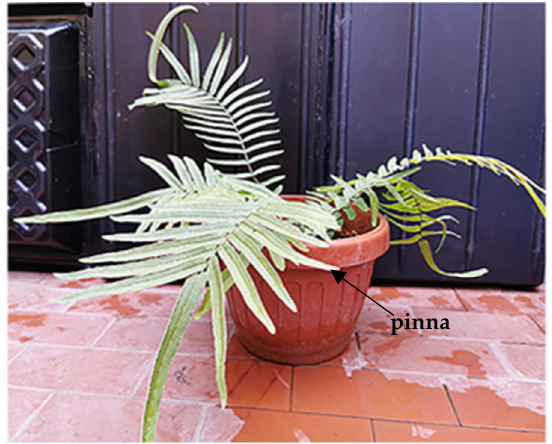
Figure 1. A P. vittata plant grown in naturally As-rich soil under greenhouse conditions. The arrow indicates the pinna collected for preparing pinna powder.